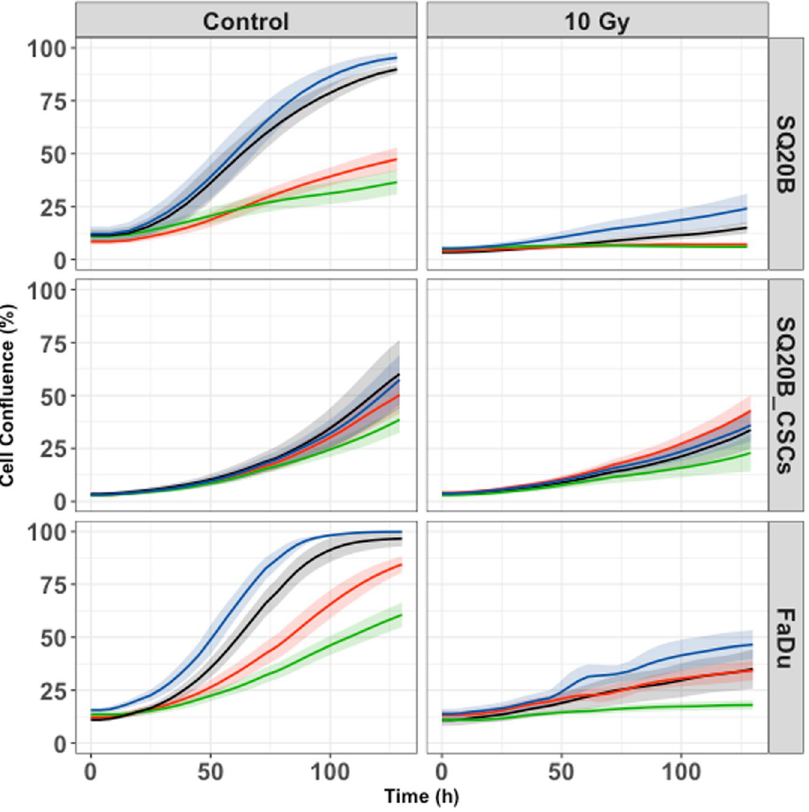
Figure 2. Cell proliferation under each treatment condition, graphically represented by the mean proliferation curves + / − standard deviation. Blue curve, control; black curve, pertuzumab 20 μ g/mL; red curve, cetuximab 5 nM; green curve, cetuximab 5 nM + pertuzumab 20 μ g/mL. Cell proliferation was measured by an IncuCyte Zoom basic analyser for each cell line under the following treatment conditions: control; cetuximab 5 nM; pertuzumab 20 μ g/mL; cetuximab 5 nM + pertuzumab 20 μ g/mL; 10 Gy; 10 Gy + cetuximab 5 nM; 10 Gy + pertuzumab 20 μ g/mL; 10 Gy + cetuximab 5 nM + pertuzumab 20 μ g/mL. Each experiment was performed in